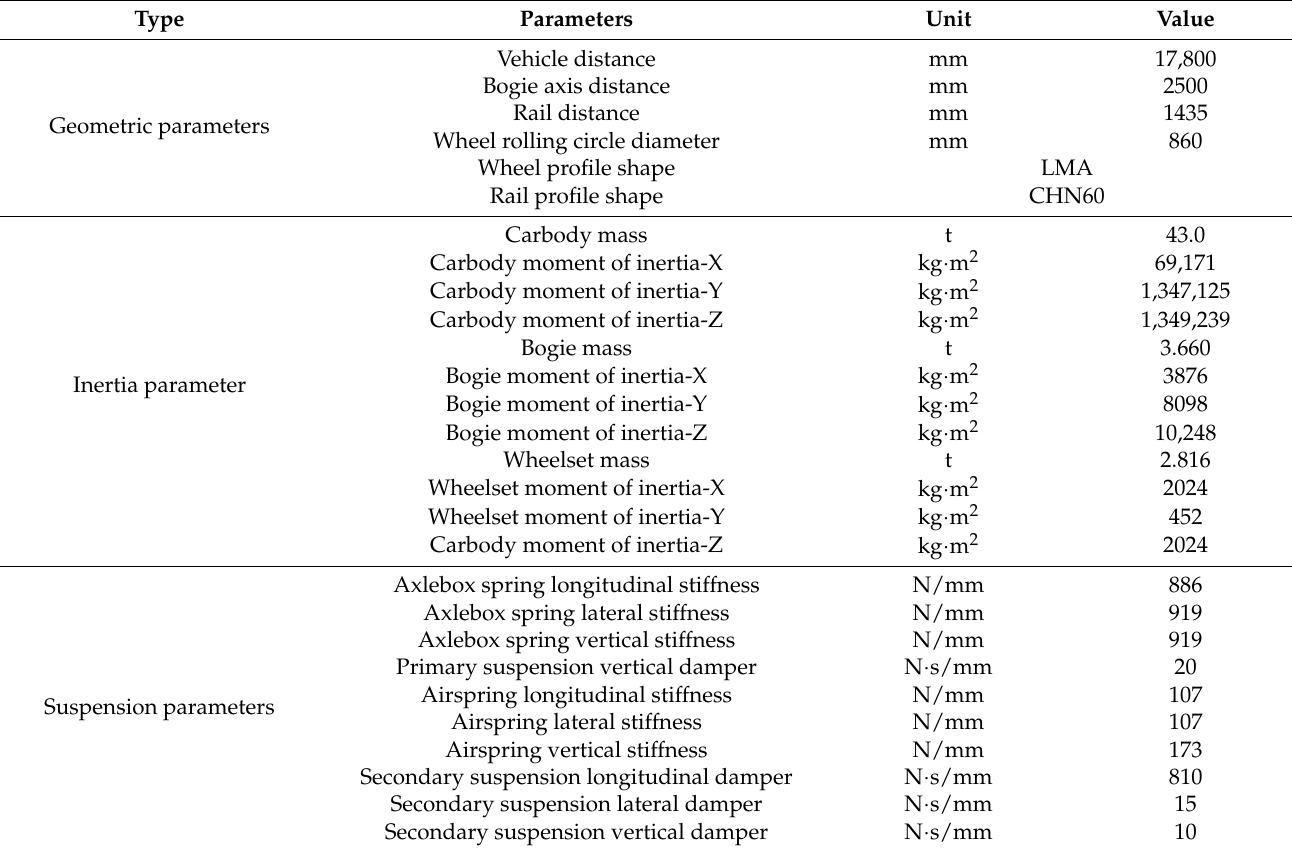
Figure 5. A vehicle dynamics model constructed with reference to a high – speed train. Table 1. Basic parameters of the high-speed